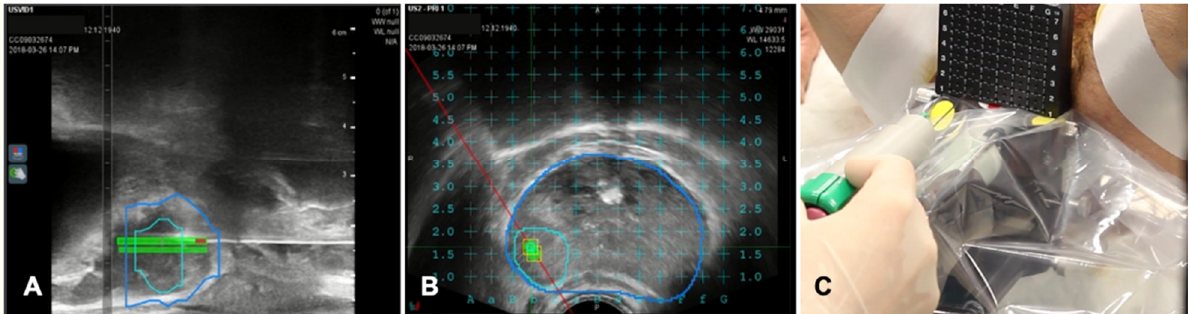
Figure 5. Case of a patient with a breast cancer femoral neck metastasis treated with cryoablation. ( A ) Axial view of the preoperative unenhanced Computed Tomography (CT) showing a lytic ovoid femoral neck lesion (white arrow); ( B ) Intraoperative setting for fusion imaging (FI): ultrasound (US) system with automatic image registration of fused images with previously acquired CT volume data sets (white arrow), a disposable locating device and sensor (white arrowheads) and electromagnetic generator (white asterisk). ( C ) Live FI with CT multiplanar reconstruction (right side) and US (left side). With combined CT-US imaging the needle (white arrow) can be oriented along the major axis of the bone lesion regardless the acoustic barrier. ( D , E ) A paraxial view and a coronal view along the needle length of the intraoperative CT confirming correct positioning into the lesion. ( F ) Final control CT on coronal plane after cryoablation and cementoplasty.